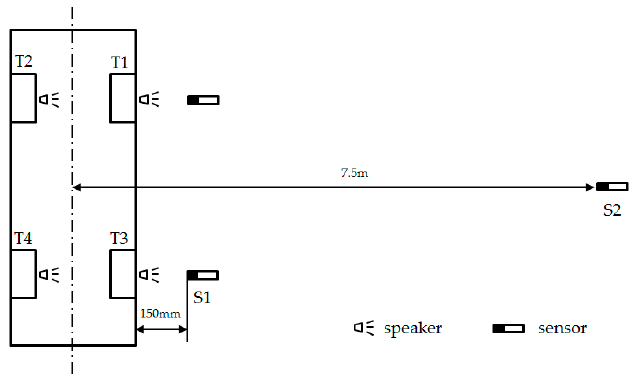
Figure 5. Tire noise radiation experiment in the semi-free field.